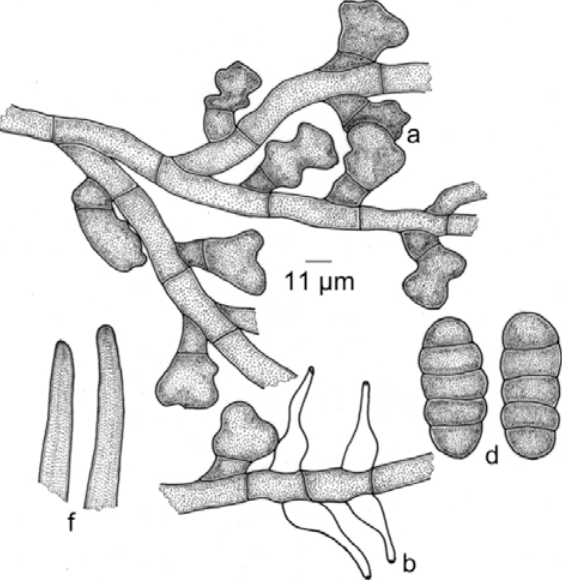
Figure 30. Irenopsis trichiliae a - Appressorium; b - Phialide; f - Apical portion of the perithecial setae; d –